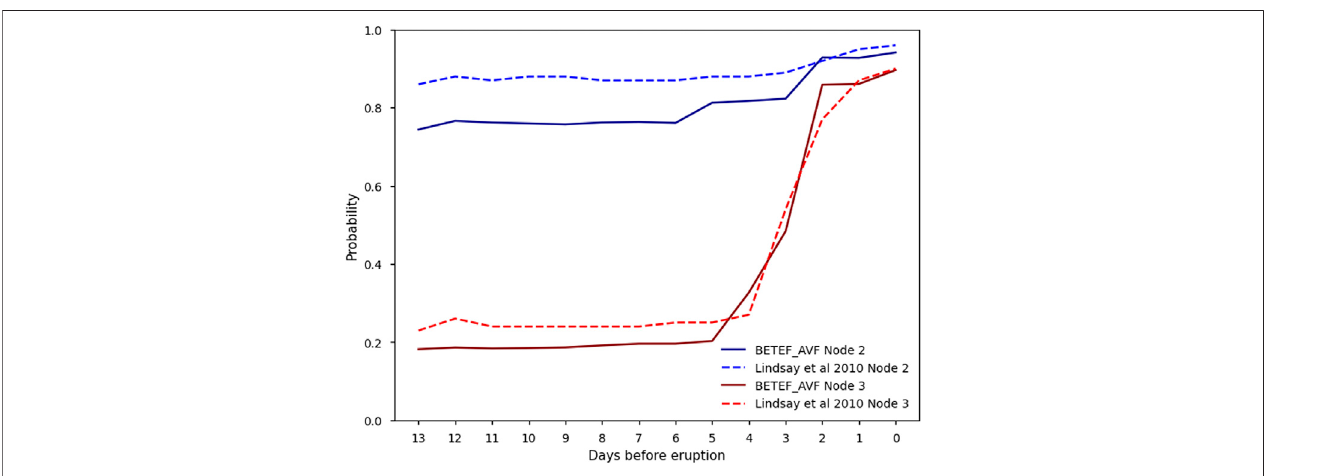
FIGURE11| Timeevolution ofBETEF_AVF for magmatic unrest and eruptionforecasting compared totheLindsay et al.(2010) outputfor theExercise R ū aumoko sequence. N.B for this comparison, BETEF_AVF uses the distributions a = U (0.5, 1) and b = U (0, 2) to align with the Lindsay et al. (2010) output